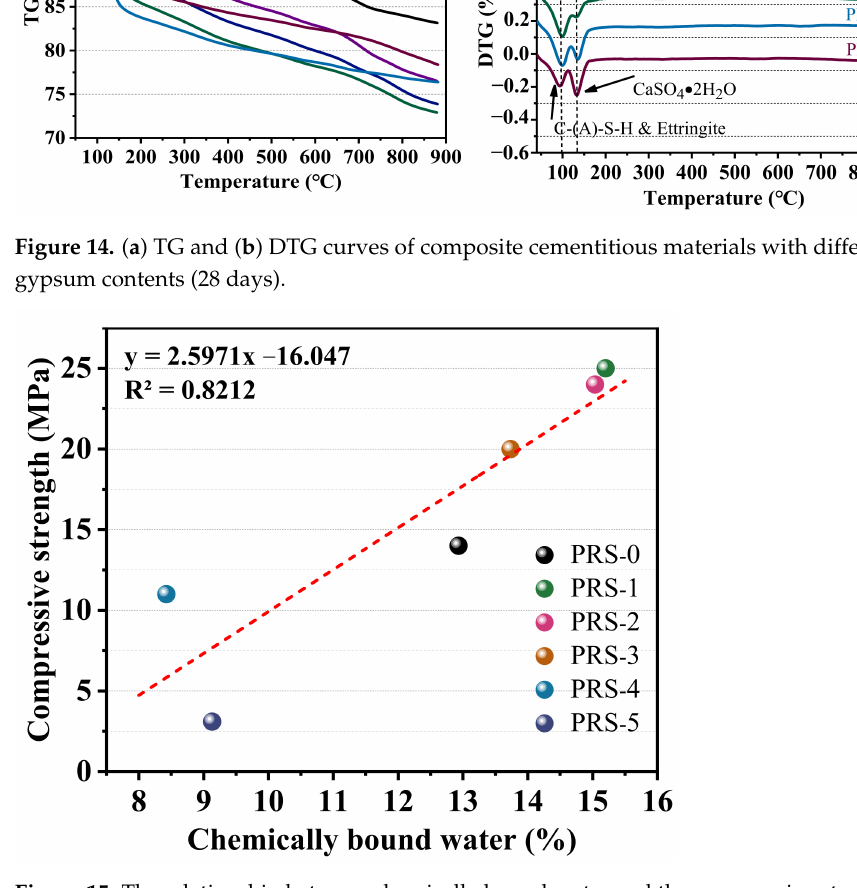
Figure 15. The relationship between chemically bound water and the compressive strength of 28-day composite cementitious materials (160–900 ◦